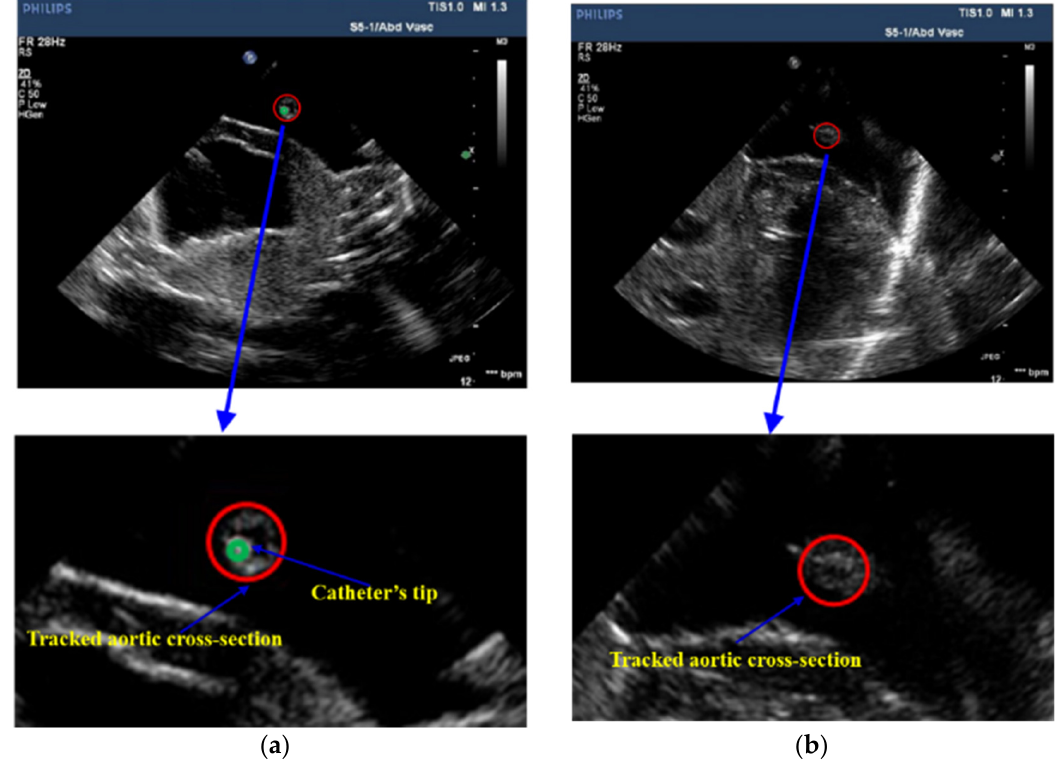
Figure 7. Tracking result of aortic cross-section and catheter’s tip in US images, ( a ) the US image which contains the catheter’s tip; ( b ) the US image which does not contain the catheter’s tip.